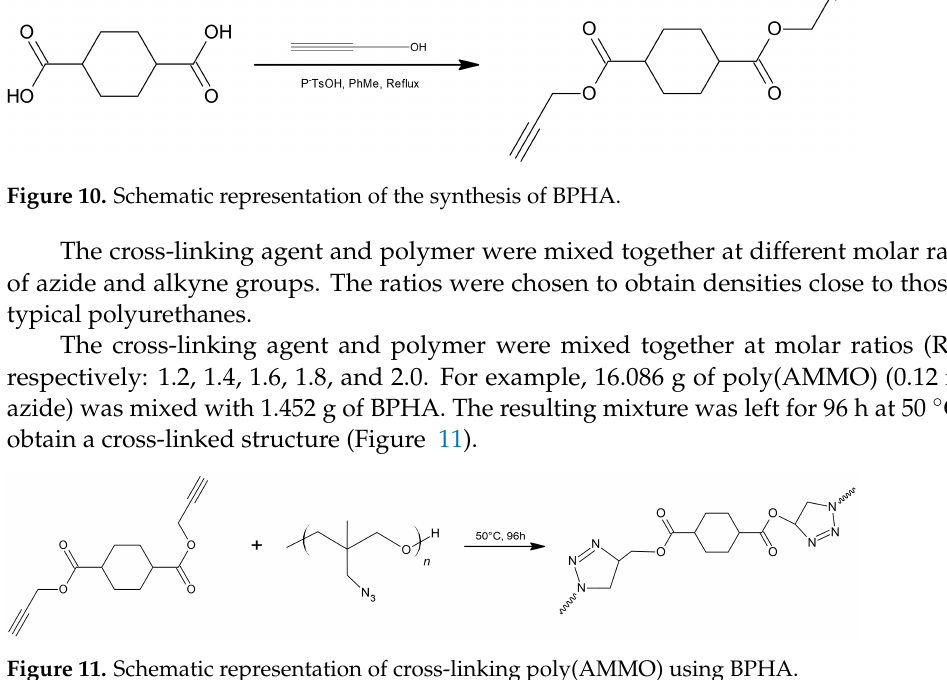
Figure 11. Schematic representation of cross-linking poly(AMMO) using BPHA.